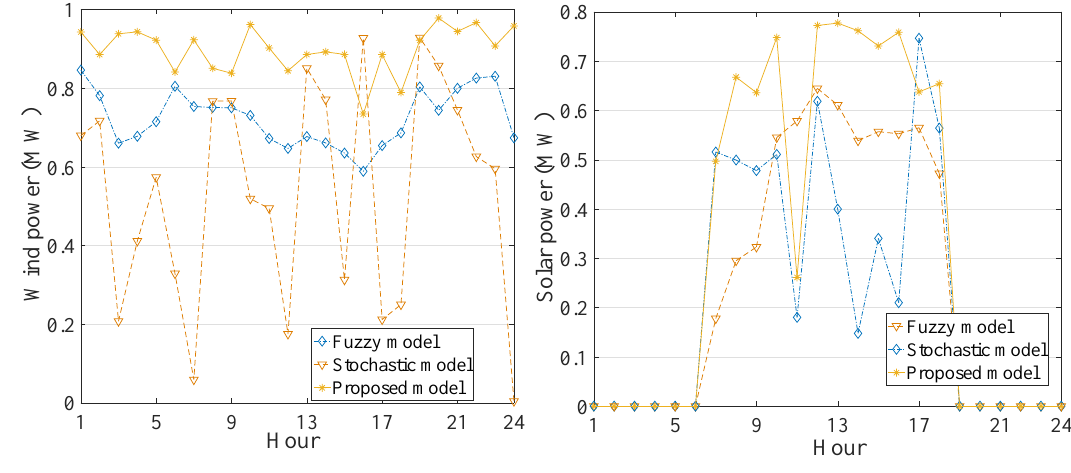
Figure 7. Optimal hourly output of wind and solar power under different